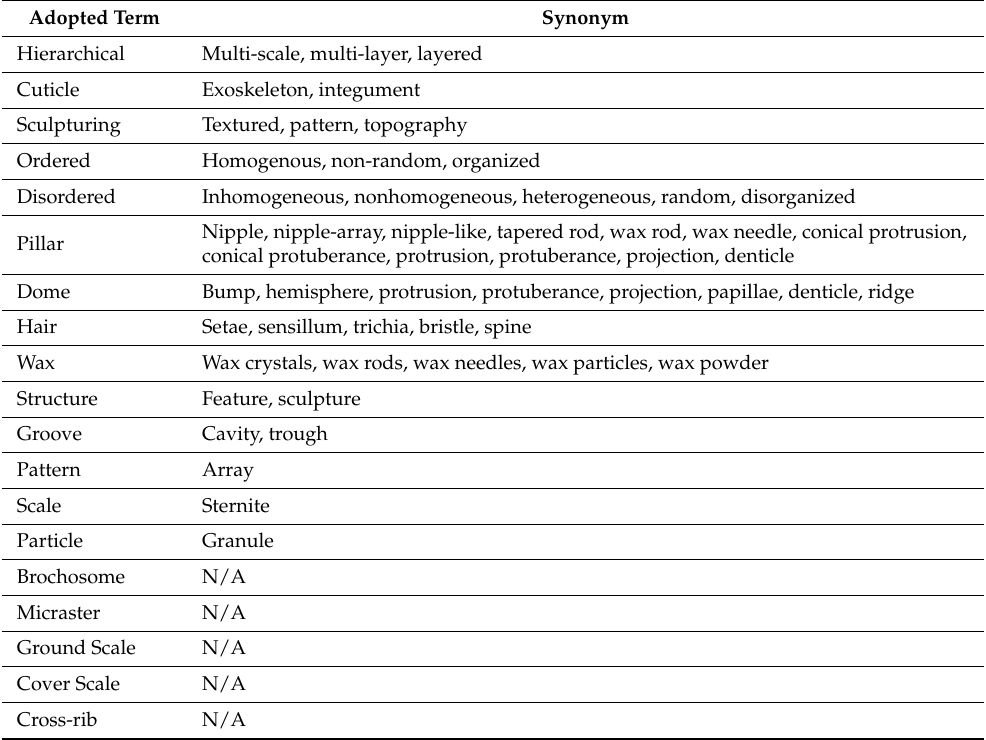
Table 1. Adopted terminology and synonyms used to describe cuticular